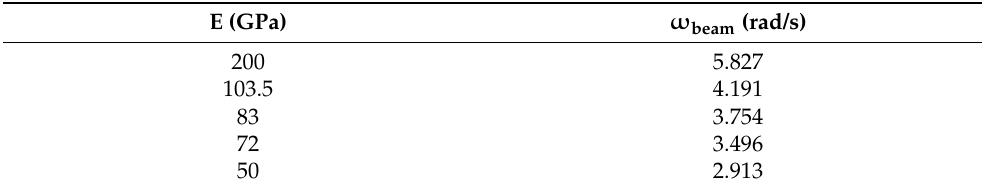
Table 5. Natural frequency of two-node vertical bending of different stiffness hull grides.